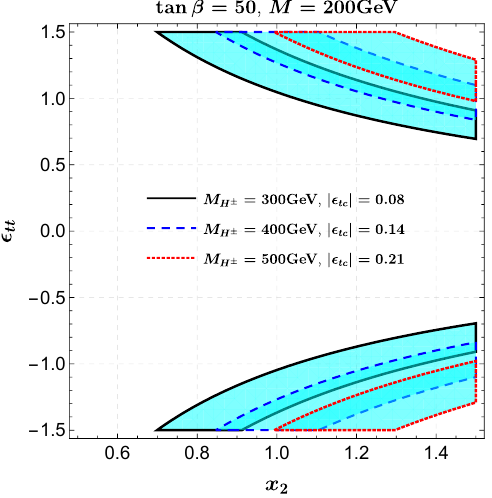
Figure 4 . Constraint on the parameters x C NP = (cid:0) C NP < 0 obtained through a global (cid:12)t to the R 9 (cid:22) 10 (cid:22) data on b ! s‘ + ‘ (cid:0) and b ! s(cid:13) transitions